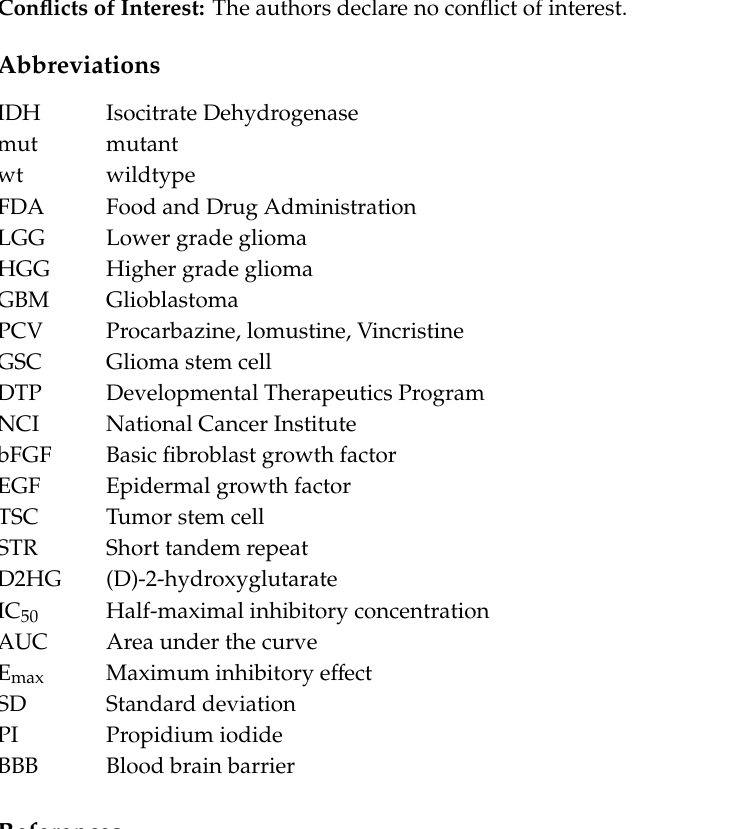
Figure S1: Exemplary dose response curves of classical treatments, Table S1: Patient and cell line characteristics, Table S2: Drug library used for screening, Table S3: Drug screening results of 147 FDA-approved drugs in NCH551b and